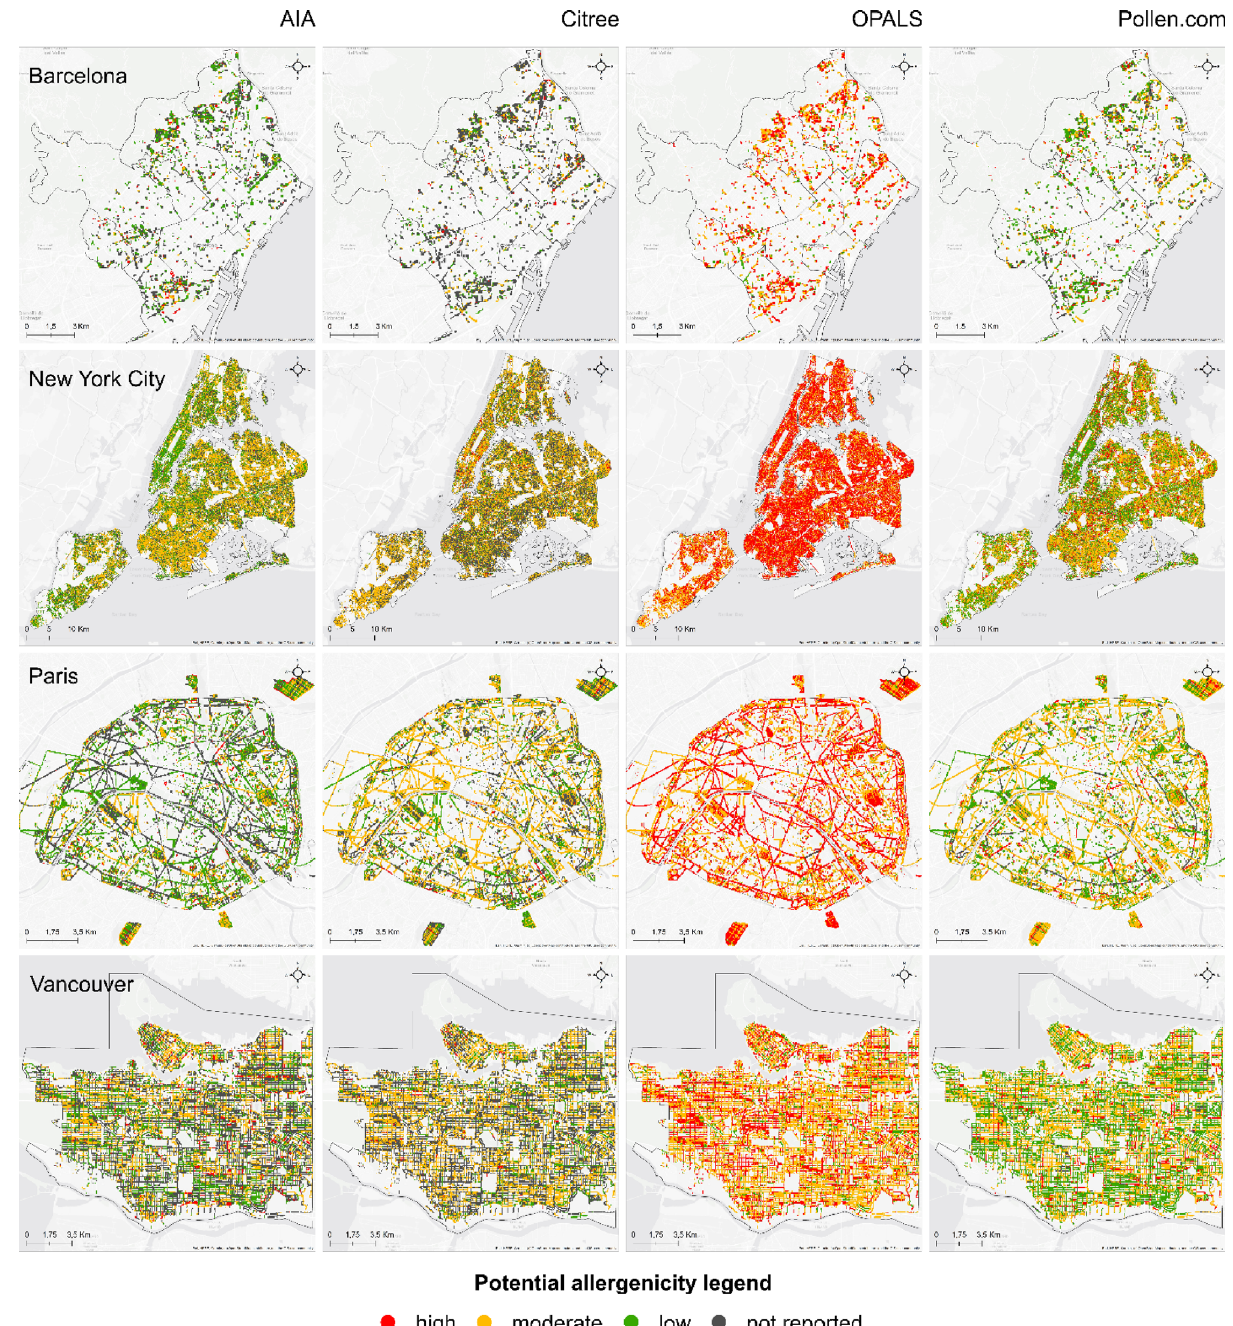
Figure 2. The allergenicity riskscape of the cities of Barcelona, New York City, Paris, and Vancouver based on the potential pollen allergenicity of the public trees analyzed in each city using different tree allergenicity data sources. Each dot represents one tree, each row corresponds to a single city, and each column to a different tree allergenicity data source. Only the AIA-, Citree-, OPALS-, and Pollen.com-based riskscapes are shown for presentation clarity and because the four datasets contained the largest numbers of species for which allergenicity is reported (for more than 100 species). Additional allergenicity riskscapes are provided in Supplementary Figs. S1–S4. Data sources are presented in Table 1. Maps were created in ArcMap 10.7.1 (http:// www. esri.